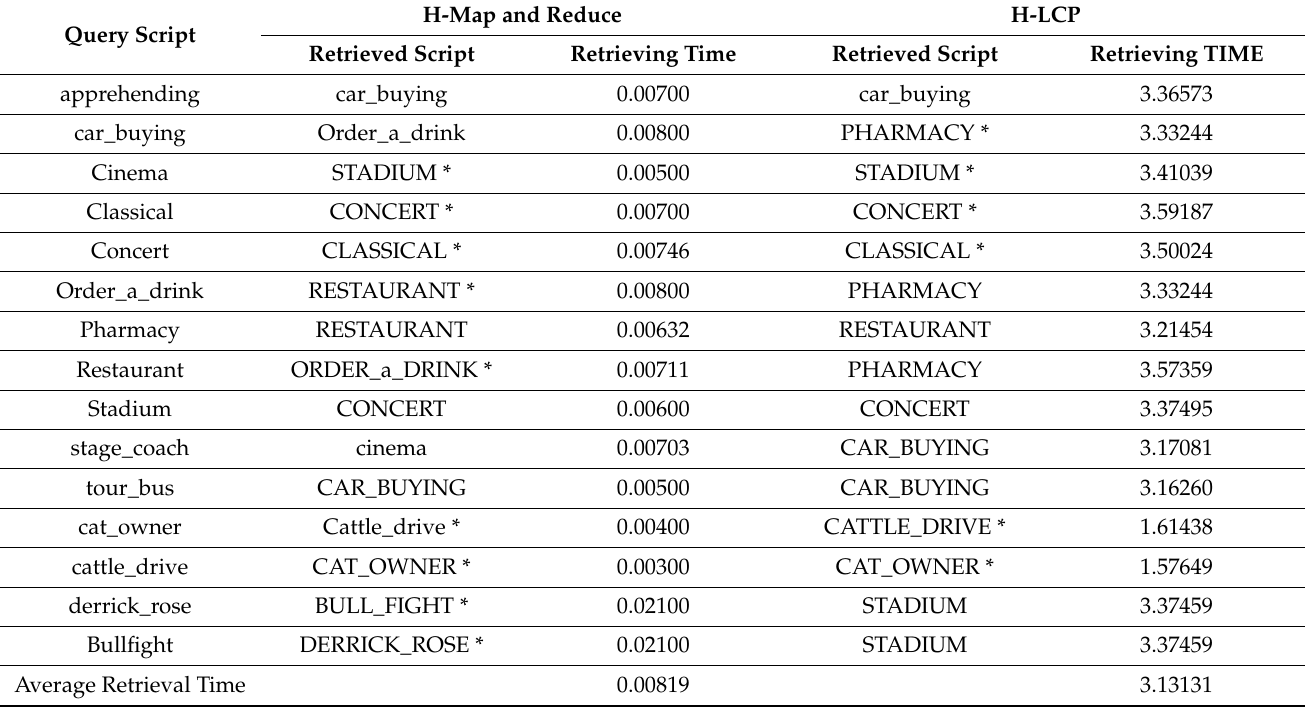
Table 4. Retrieved scripts based on H-Map-Reduce and